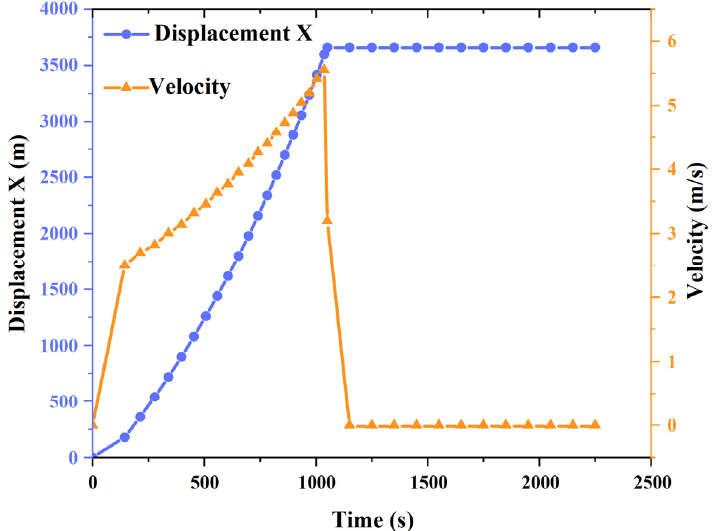
Figure 4. Upward and renewal phase displacement and velocity of the